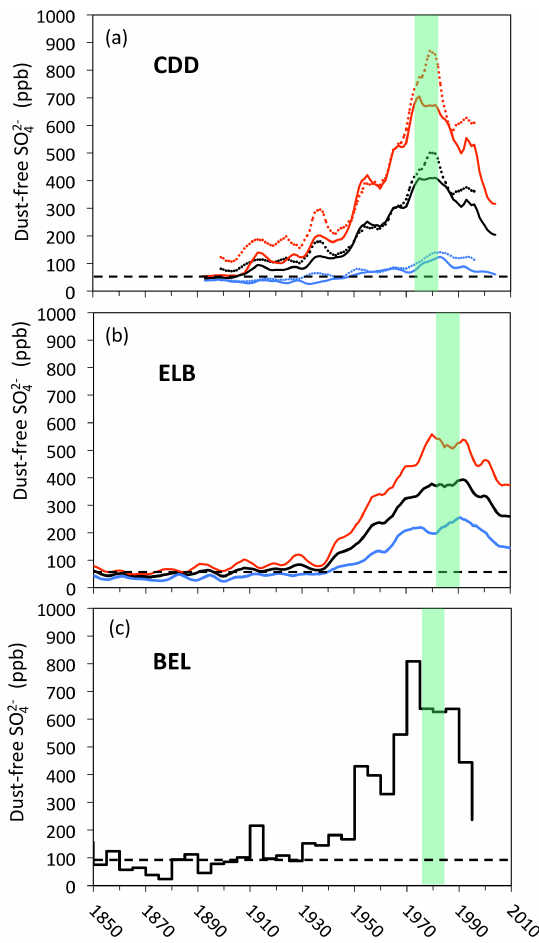
Figure 11. Dust-free sulfate (annual values in black, summer in red, and winter in blue) trends at the CDD (a) , ELB (b) , and BEL (c) sites. For CDD we report the records derived from the C10 (dashed lines) and CDK (solid lines) ice cores (see Sect. 5.1). Green areas indicate the decades in which the sulfate levels reached their maxima.